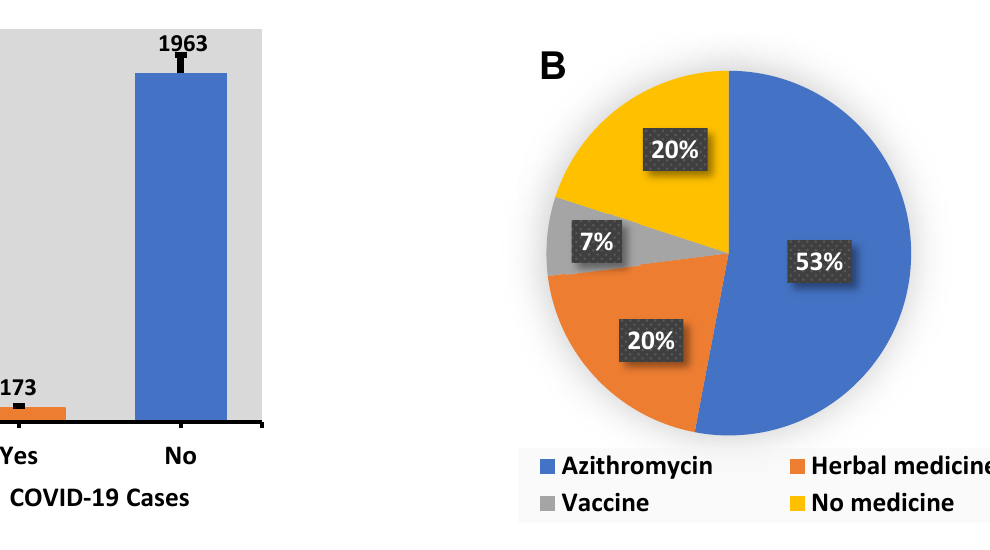
Figure 3. ( A ) Skin discomfort/irritation. ( B ) Other side effects as indicated by the respondents. Error bars represent the percentage of skin discomfort and other related side effects.